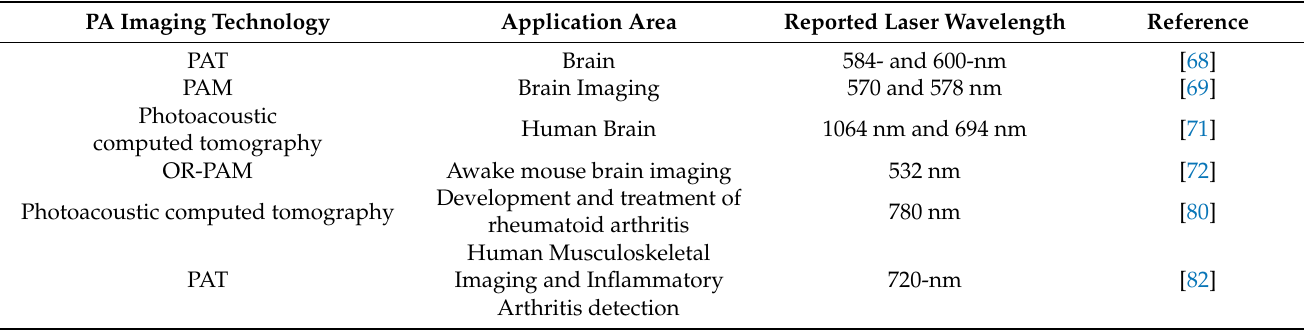
Table 1. Different Photoacoustic Technologies and its